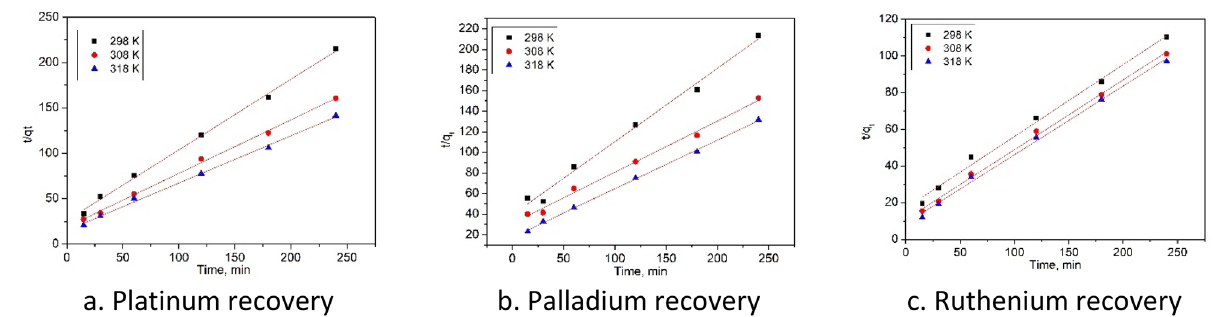
Figure 9. Pseudo-second-order kinetic model of the Pt(IV), Pd(II) şi Ru(III) recovery by